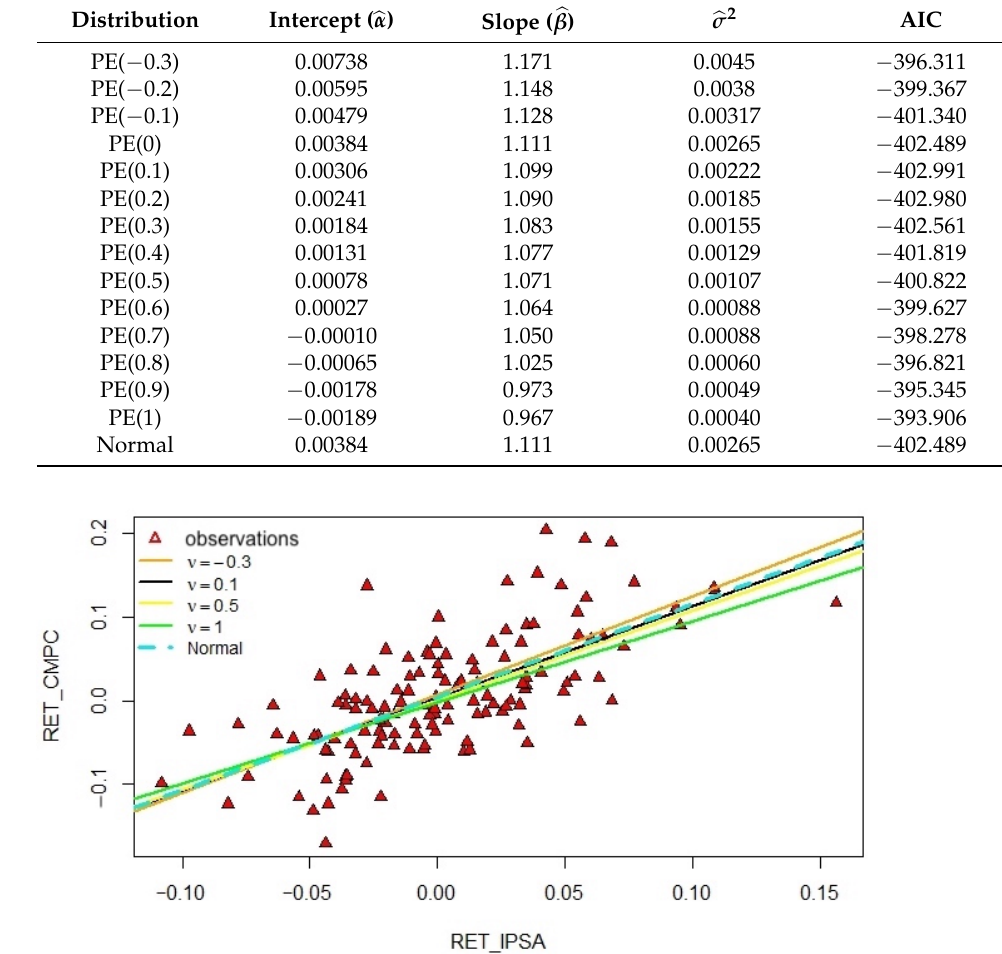
Table 6. CAPM fit under the PE distribution with data of monthly returns.